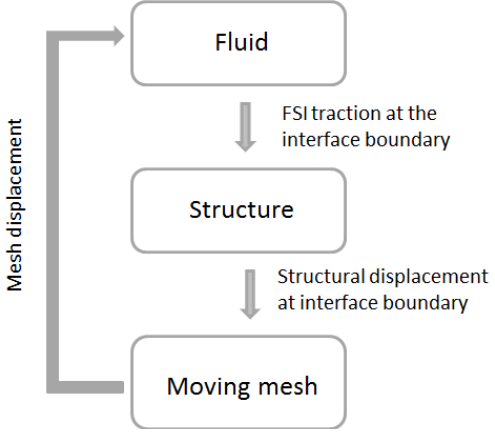
Figure 4. Schematic diagram of fluid-structure